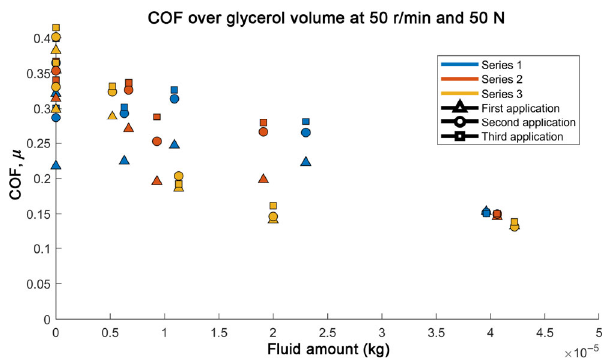
Fig. 13 COF vs. amount of fluid for the system with the coarsely filed pin, zoomed in range